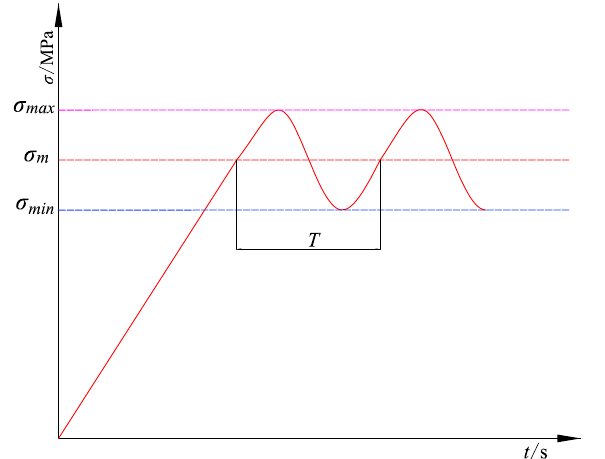
Figure 5. Schematic of the wave for the loading cycle.